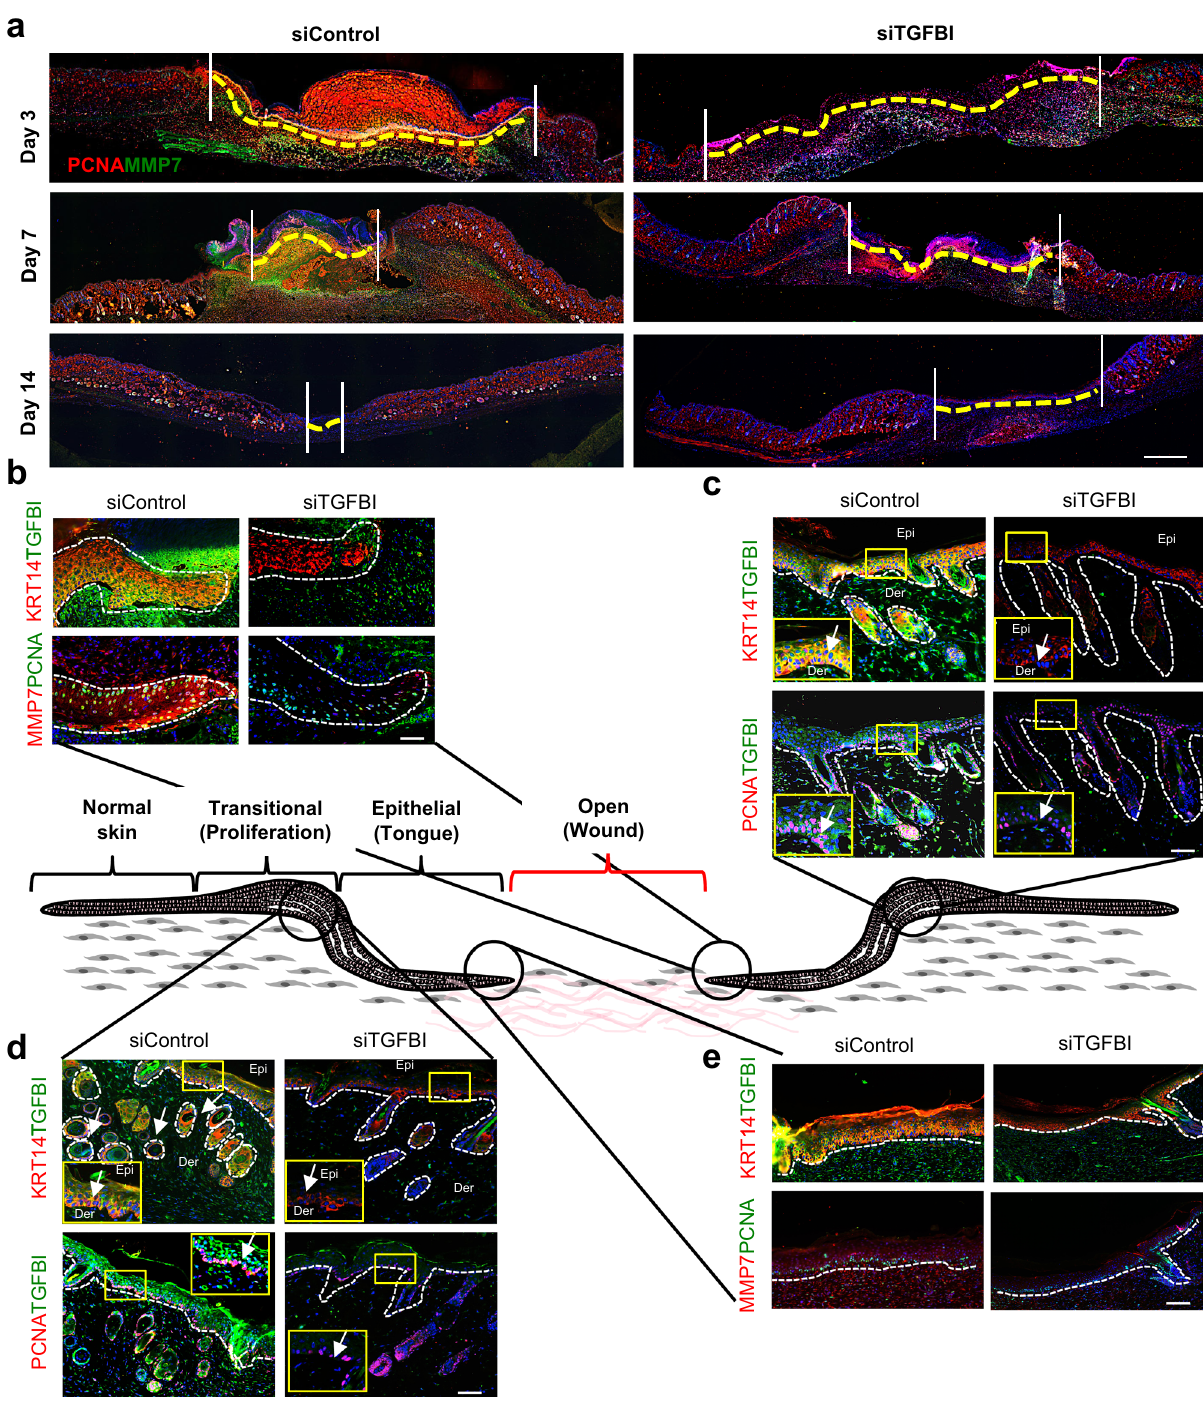
Fig. 6 TGFBI promoted cutaneous wound healing through the enhancement of re-epithelialization. a Immuno fl uorescence of wound healing on mouse skin under siTGFBI treatment at Days 0, 3, 7, and 14 ( n = 3 per group, scale bar: 800 μ m). Yellow dotted lines indicate unwounded skin areas. Immuno fl uorescence of MMP7, KRT14, TGFBI, and PCNA during the process of wound healing on mouse skin proliferation and tongue sites at Day 7 ( b , c ) and Day 14 ( d , e ) (scale bar: 50 μ